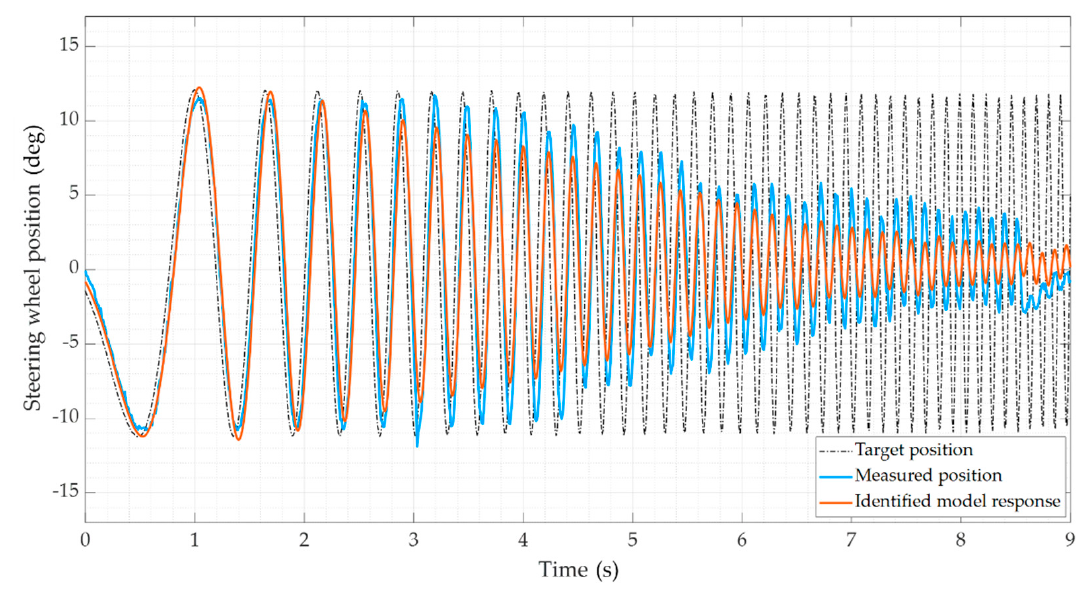
Figure 9. Steering wheel position behavior during the performed sine-sweep maneuver for validating the system identifica- tion: target position (black, dash-dotted) vs. measured position (blue, solid) vs. identified model response (orange, solid).